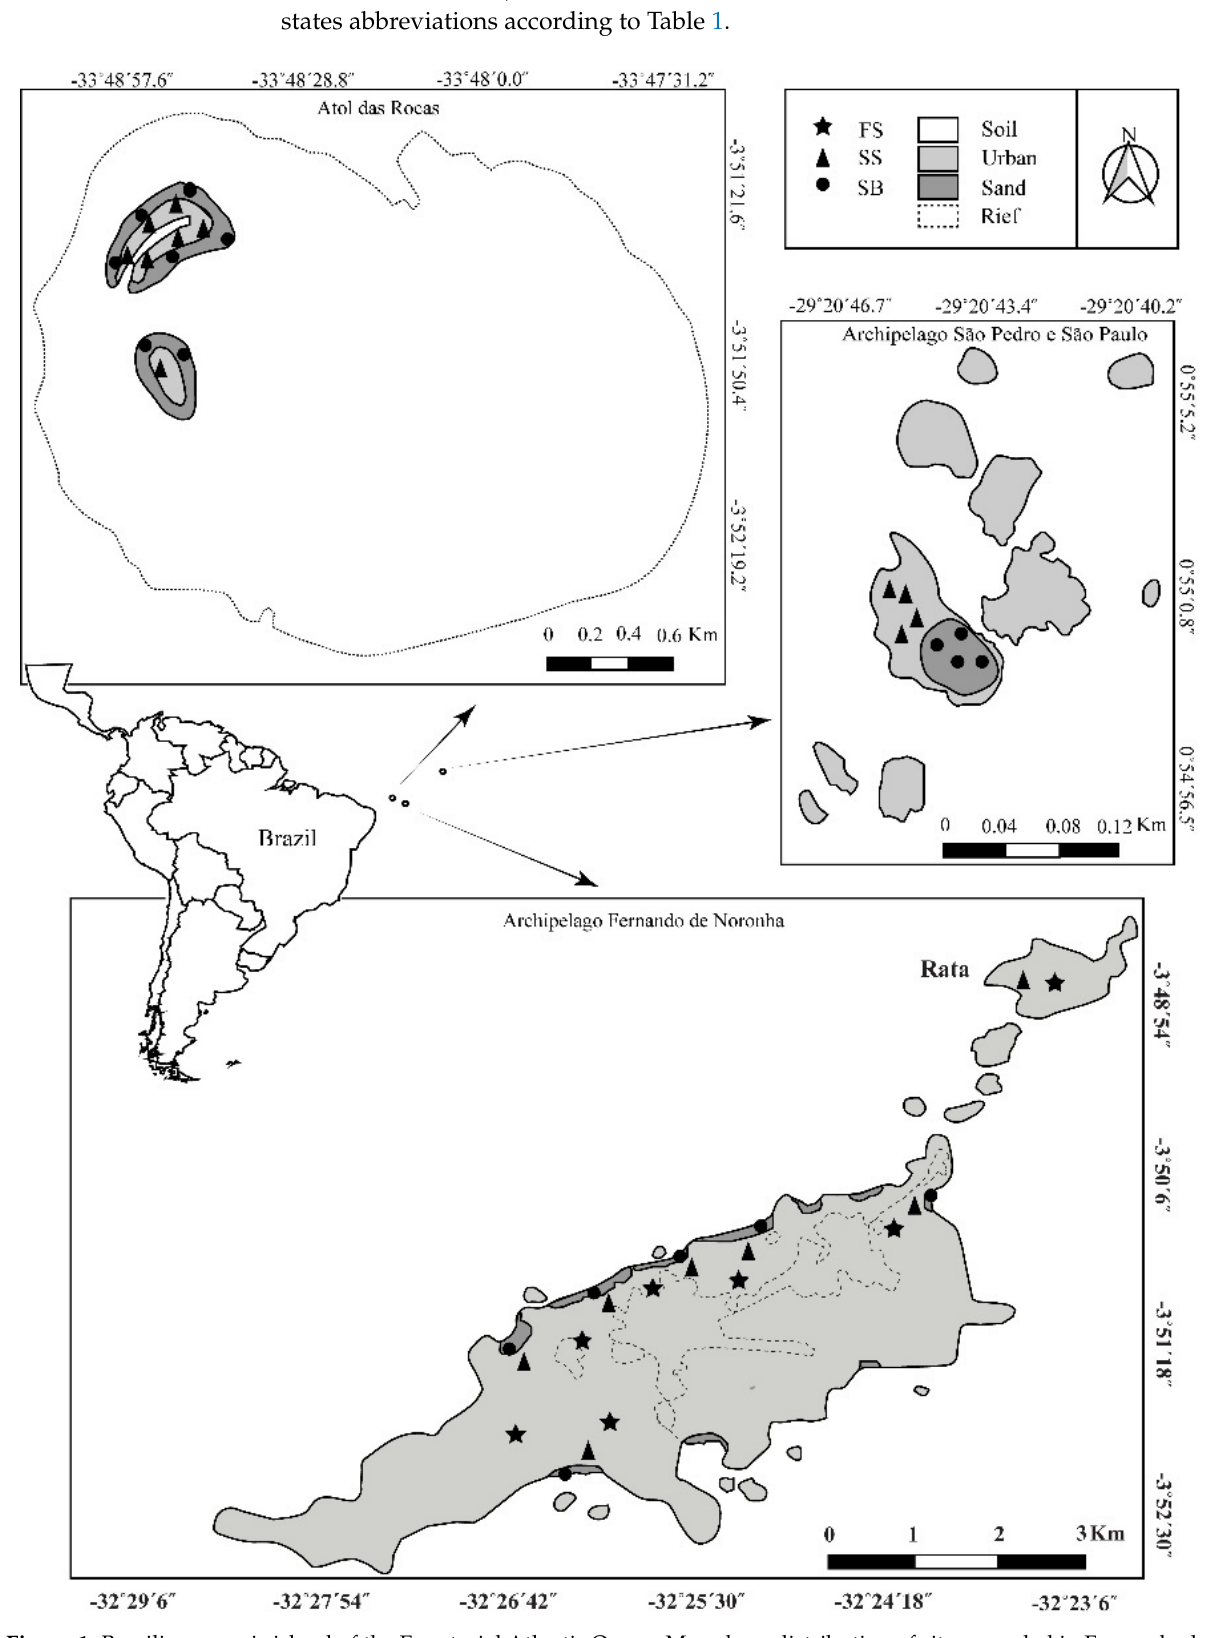
Figure 1. Brazilian oceanic island of the Equatorial Atlantic Ocean. Map show distribution of sites sampled in Fernando de Noronha archipelago, Atol das Rocas (Rocas Atoll) and São Pedro e São Paulo Archipelago.